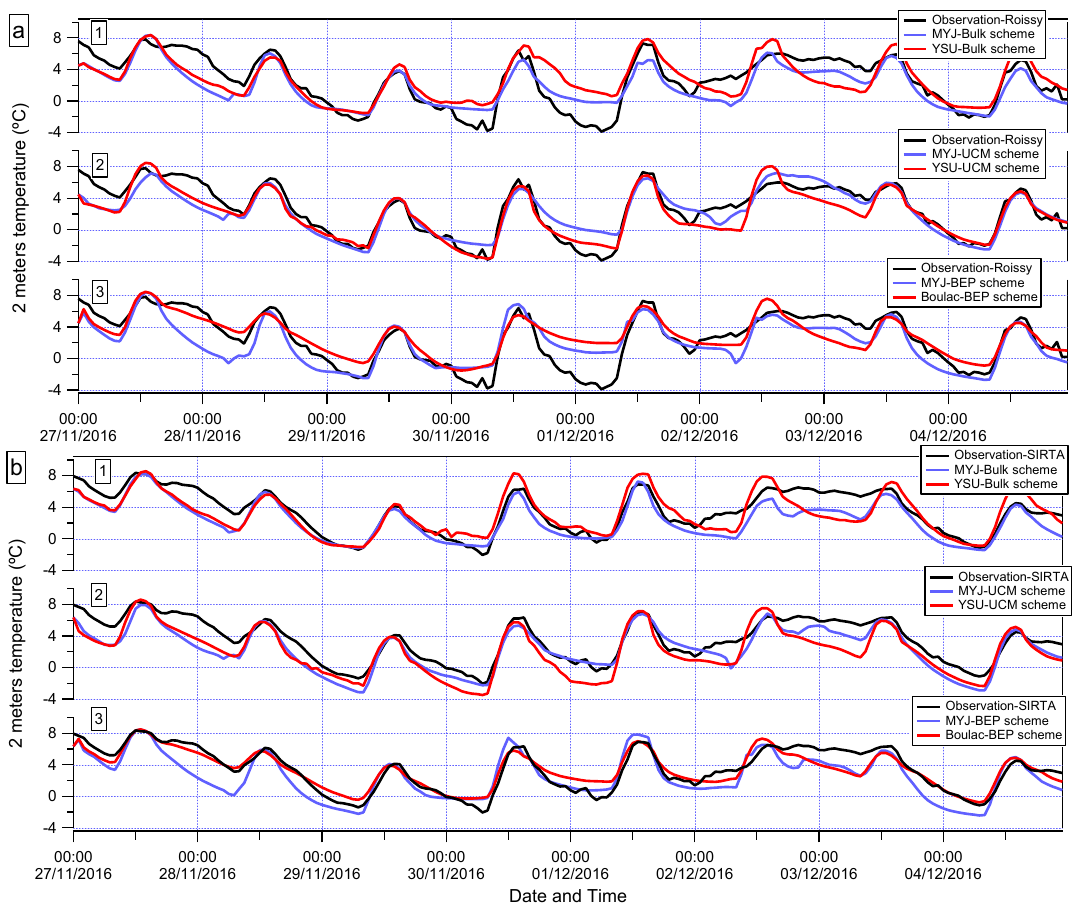
Figure 15. Time series between the observed and modelled T2: ( a ) and ( b ) represent Roissy and Sirta station, respectively; 1, 2, and 3 represent each PBL scheme coupled with each urban canopy scheme.